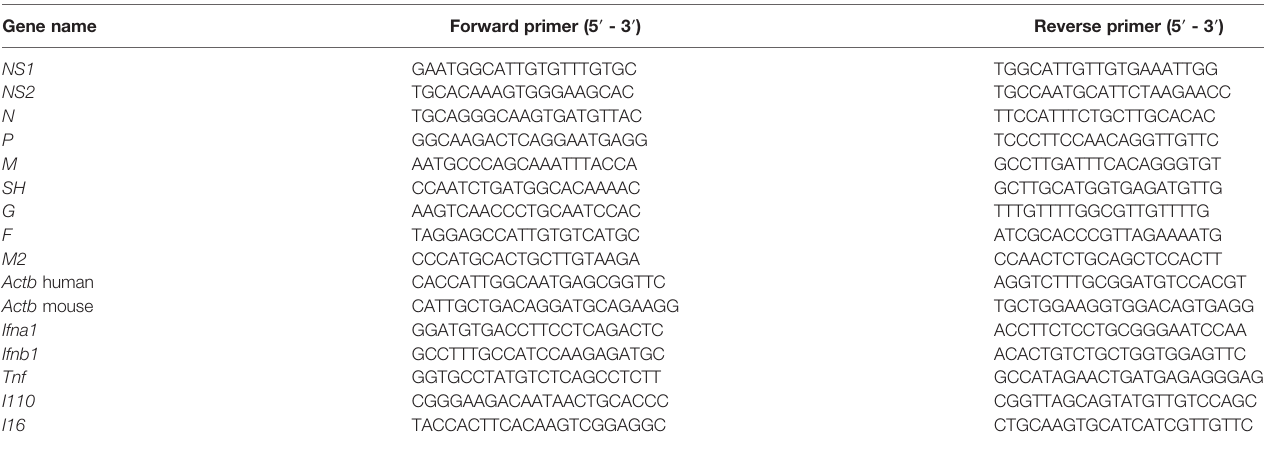
TABLE 1 | Oligonucleotides used for